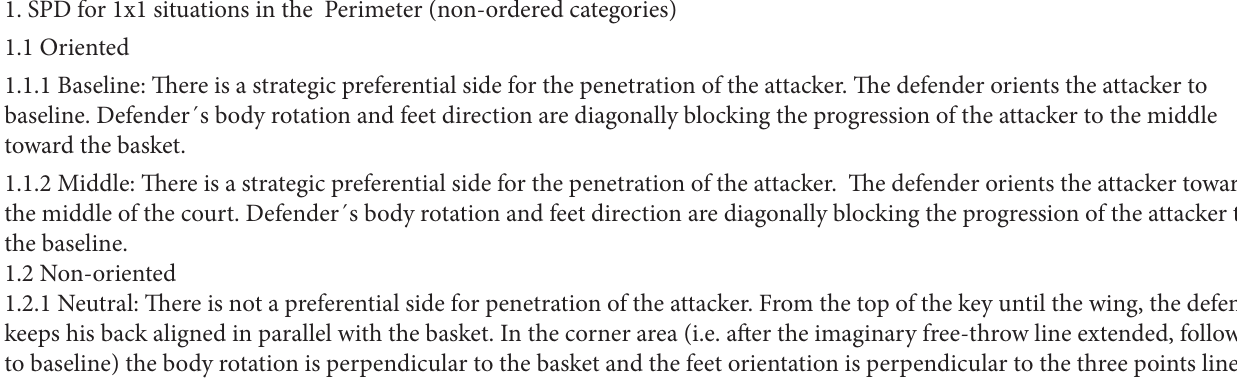
Table 1. SPD classes for offense versus defense interactions involving 1x1, 2x2 and 3x3